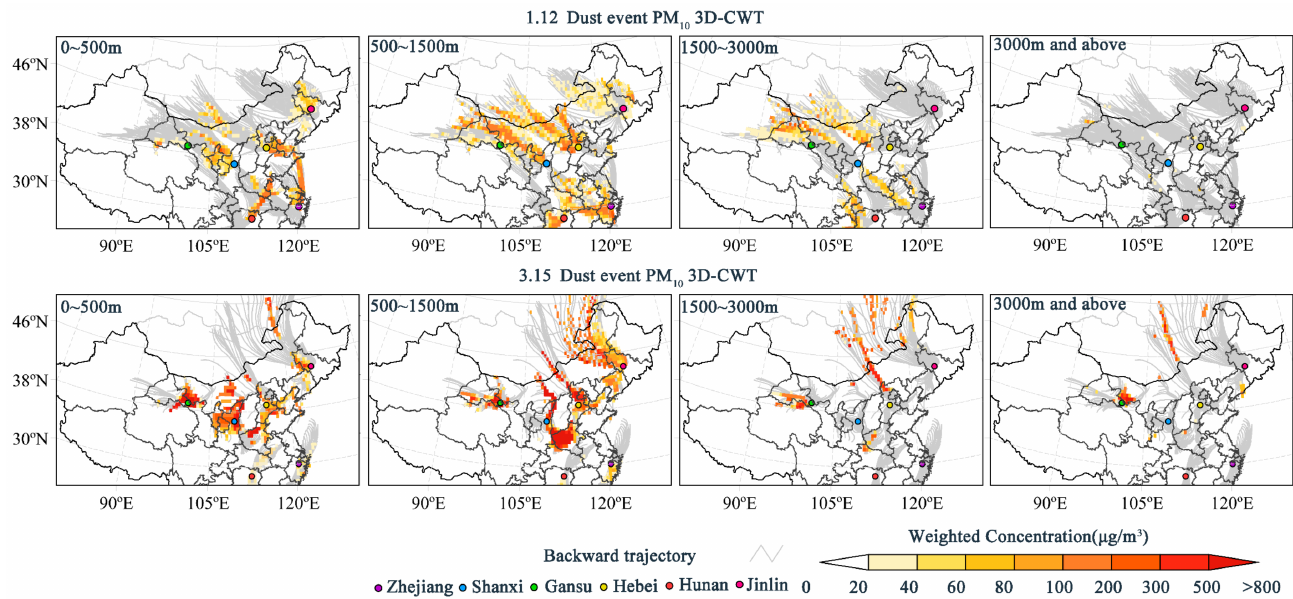
Figure 8. PM 10 3D-CWT results for typical cities in the 1.12 and 3.15